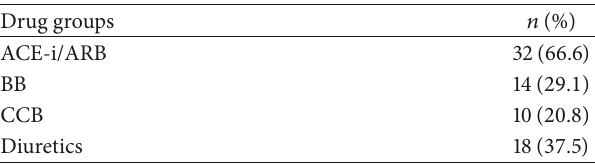
Table 3: Distribution of patients in antihypertensive medicine groups.